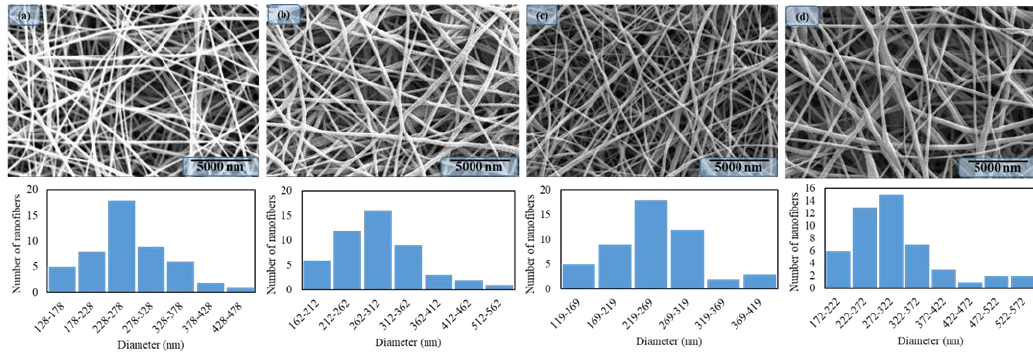
Figure 2. SEM images & nanofibers diameter distributions of Neat PAN nanofibers: ( a ), PAN/AgNPs nanofibers having one dipping cycle: ( b ), PAN/AgNPs nanofibers having two dipping cycles: ( c ), and PAN/AgNPs nanofibers having three dipping cycles: ( d ).